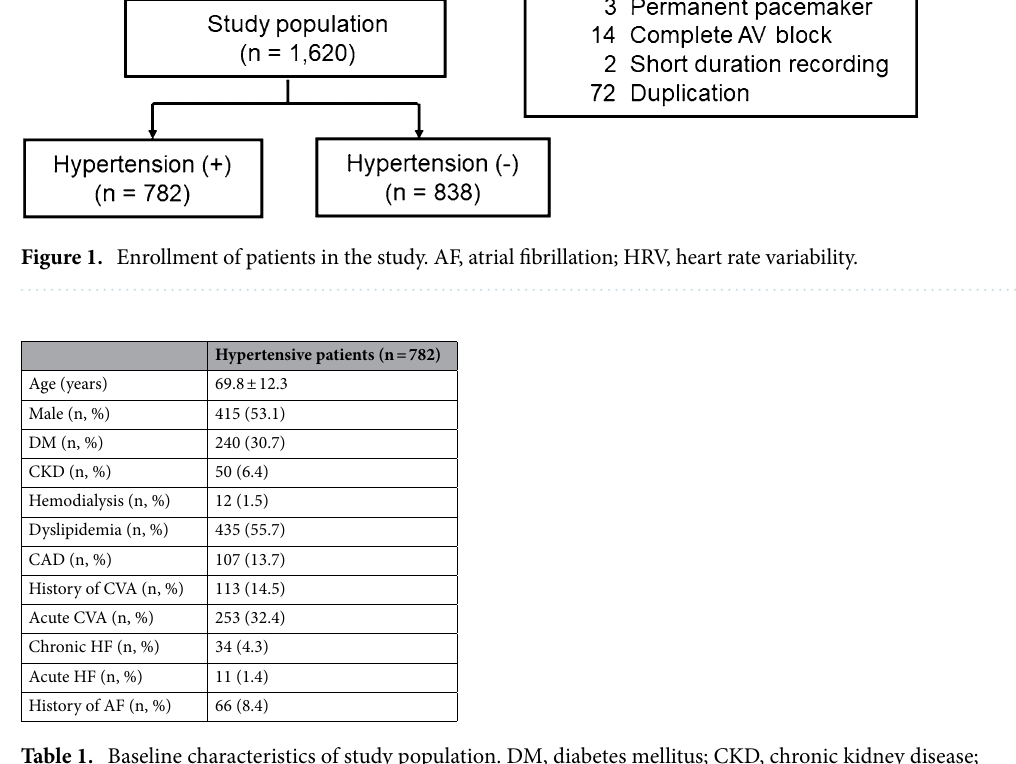
Table 1. Baseline characteristics of study population. DM, diabetes mellitus; CKD, chronic kidney disease; CAD, coronary artery disease; CVA, cerebrovascular accident; HF, heart failure; AF, atrial